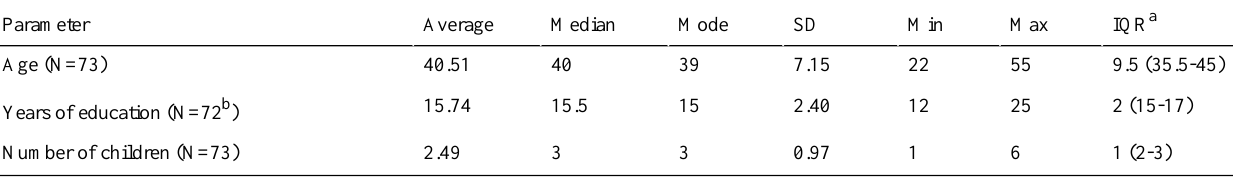
Table 1. Demographic statistics of parents (n=73).